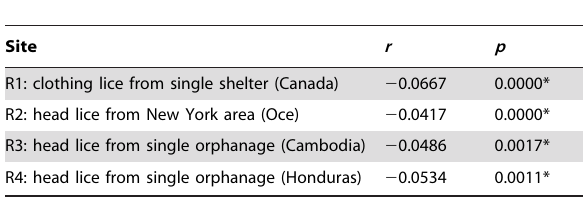
Table 3. Whole population relatedness values ( r